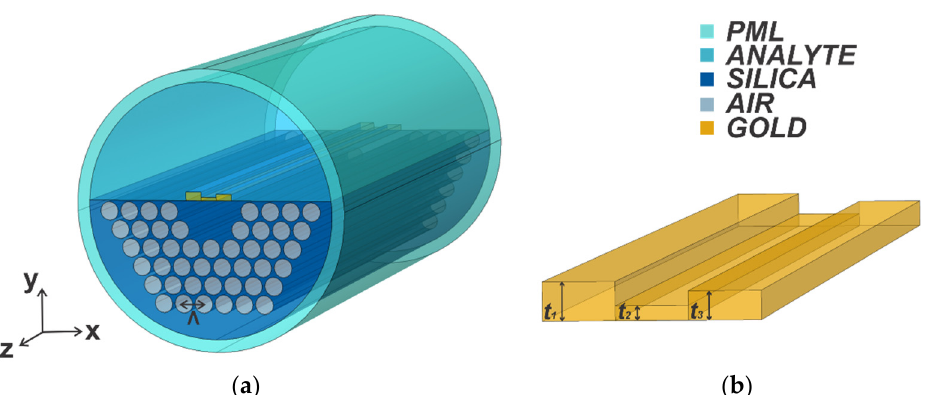
Figure 1. D-shaped photonic crystal fiber with three gold slabs. ( a ) Perspective view of the sensor with diameter D = 24 µm, diameter of air holes d = 1.76 µm and Λ = 2 µm. The outermost layer that encloses the entire domain corresponds to a 0.1D thick PML. ( b ) Highlight of the three gold slabs deposited on the top of the flat face of the PCF. They present an equal 1.5 µm width but with different thicknesses: t 1 = 40 nm, t 2 = 15 nm and t 3 = 30 nm.